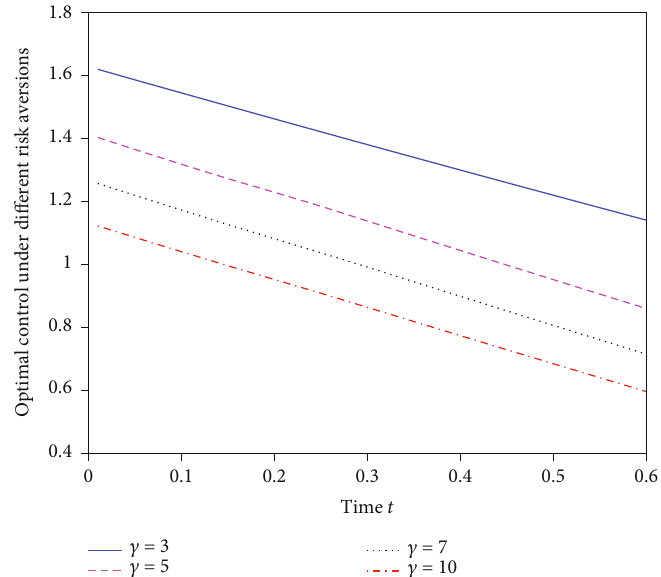
Figure 1: Optimal investment ratio u ∗ with di ff erent γ :